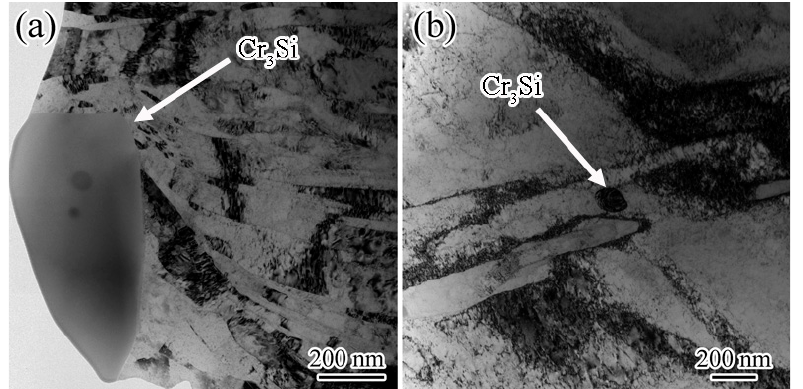
Figure 6. TEM images of CR CuNiSi-0.30Cr alloys with Cr 3 Si particles: ( a ) large particles at grain boundaries and ( b ) small particles inside grains.